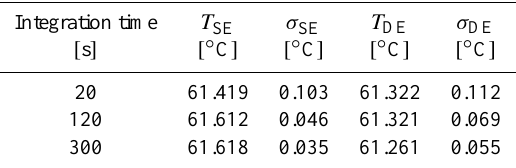
Table 2. Comparison between single-ended (SE) and double- ended (DE) measurements in the hot bath (obtained using the manufacturer-internal calibration method). T is average tempera- ture and σ is standard